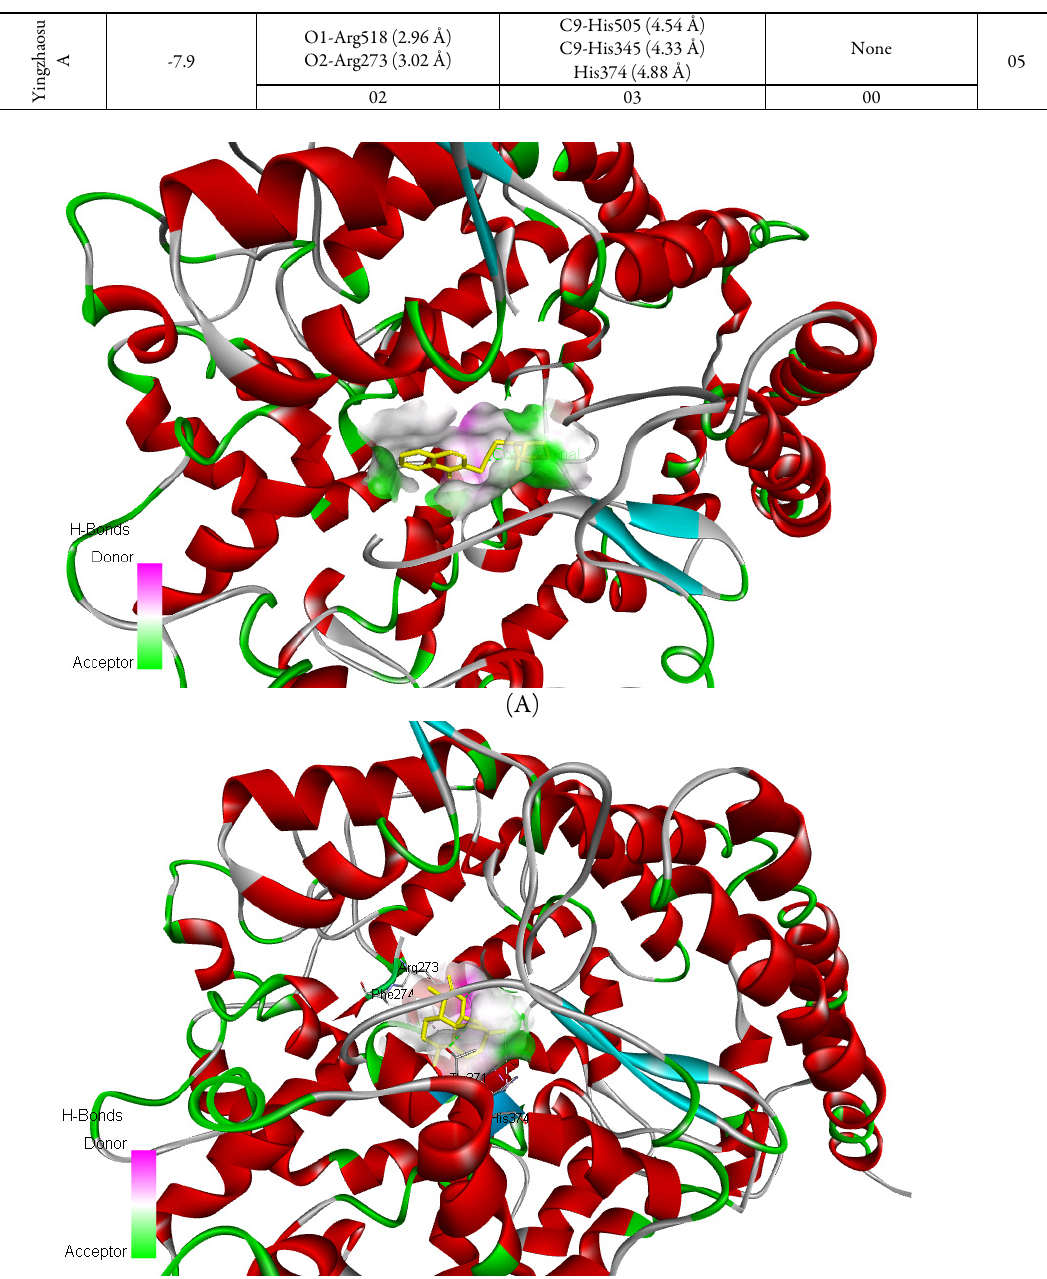
Figure 1. 3D illustration showing the interaction of the ACE 2 receptor with the ligands tested. A; ACE2 receptor complexed with the febrifugine. B; ACE2 receptor complexed with the